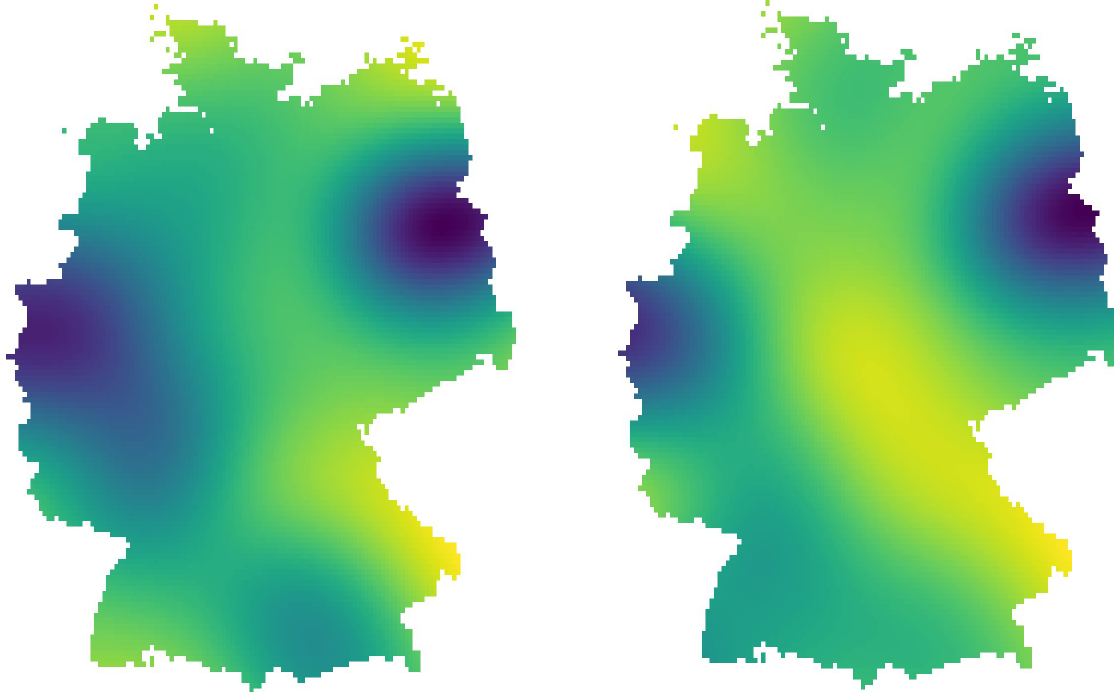
Fig 2. Density plots with gradients of spatial aggregation of media reports (left) and ‘Mu¨ckenatlas’ submissions (right). The darker the colour, the more submissions or media reports,